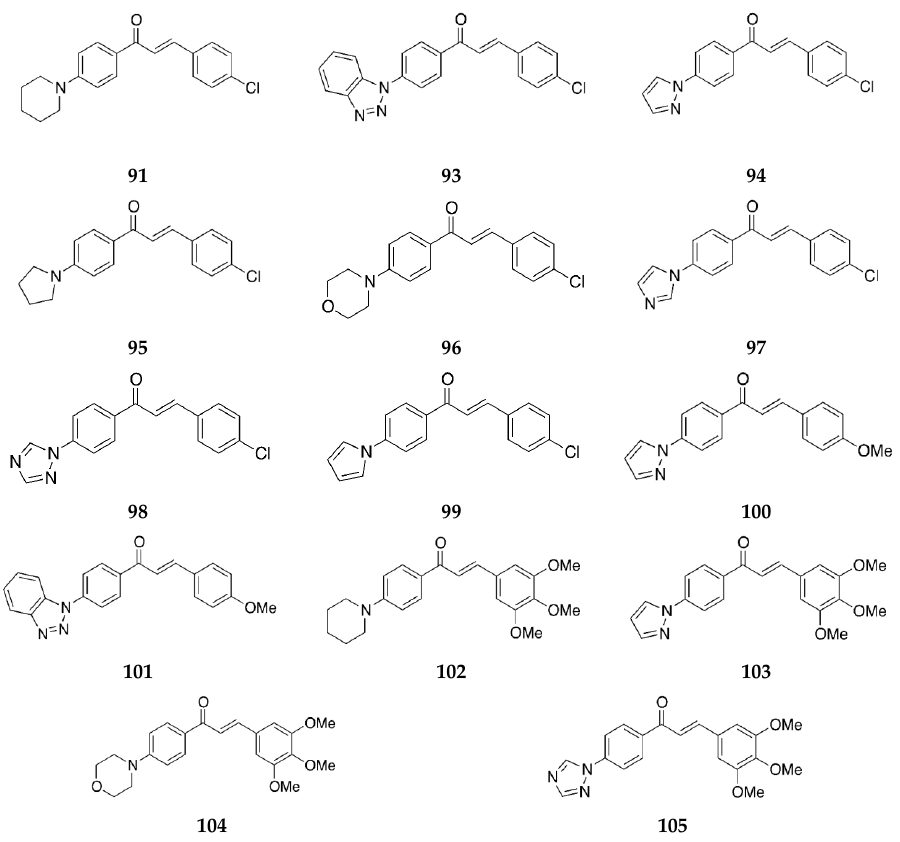
Figure 45. Chemical structures of N,N -dialkylated 4-aminochalcone derivatives.